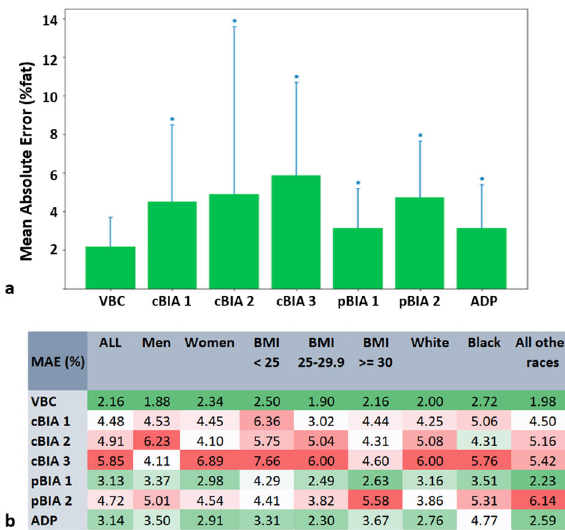
Fig. 2 Accuracy of different measurement methods. Mean absolute errors (MAE) of the various methods evaluated with DXA as the reference a . MAE of various methods in comparison to DXA strati fi ed by sex, BMI, and ethnicity b . The colors are interpolated linearly from green (low error) to red (high error). We de fi ned an acceptable error range as ≤ 3% (dark green). This value was selected as the mean MAE for ADP and the best of the pBIA devices. Light green, white, and red shadings indicate errors outside of this range. * p < 0.05 in comparison to VBC-DXA